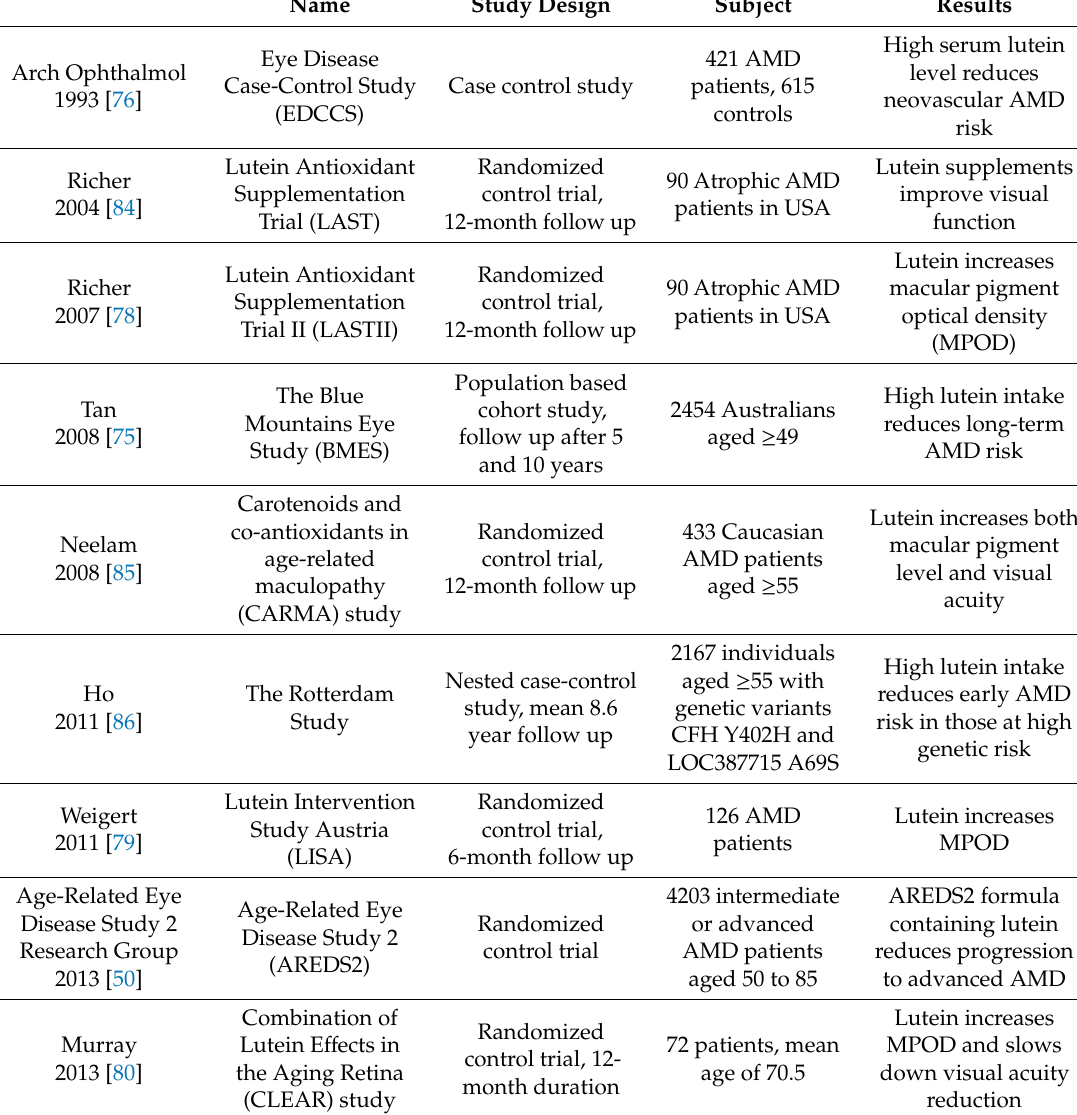
Table 4. Studies indicating protective e ff ects of lutein for